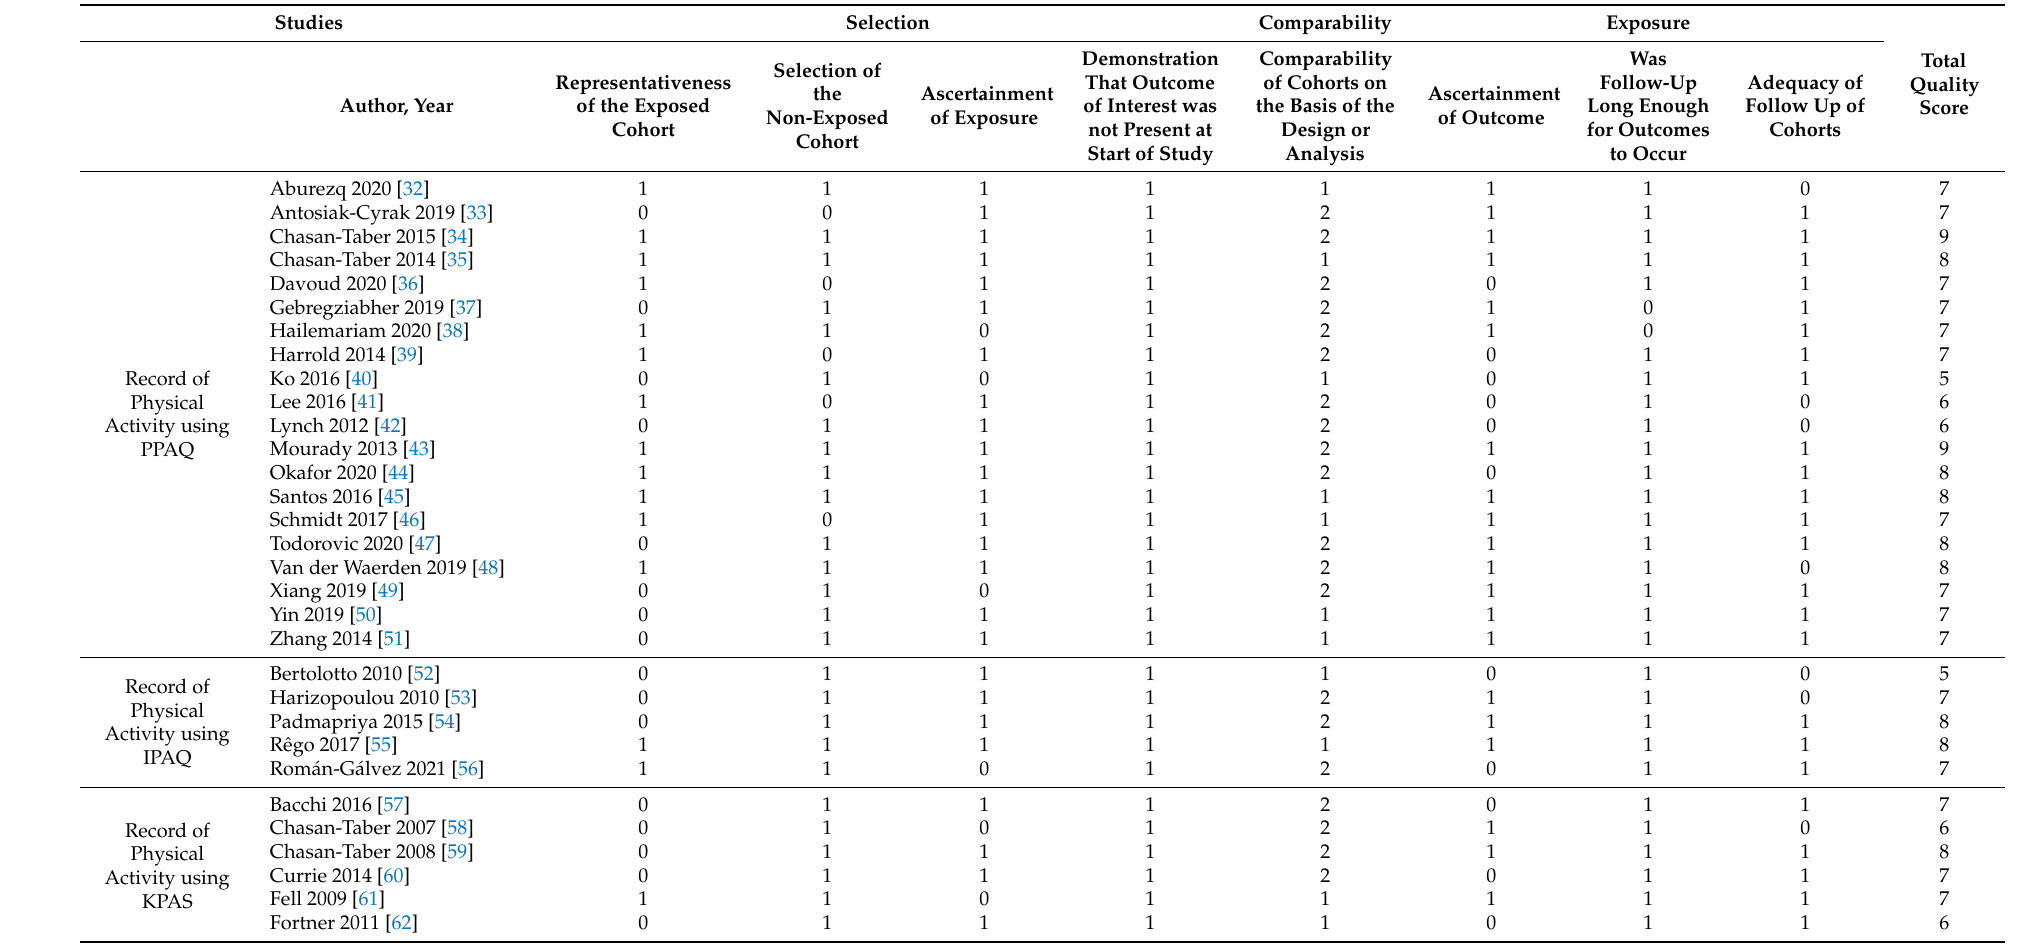
Table 2. NOS quality